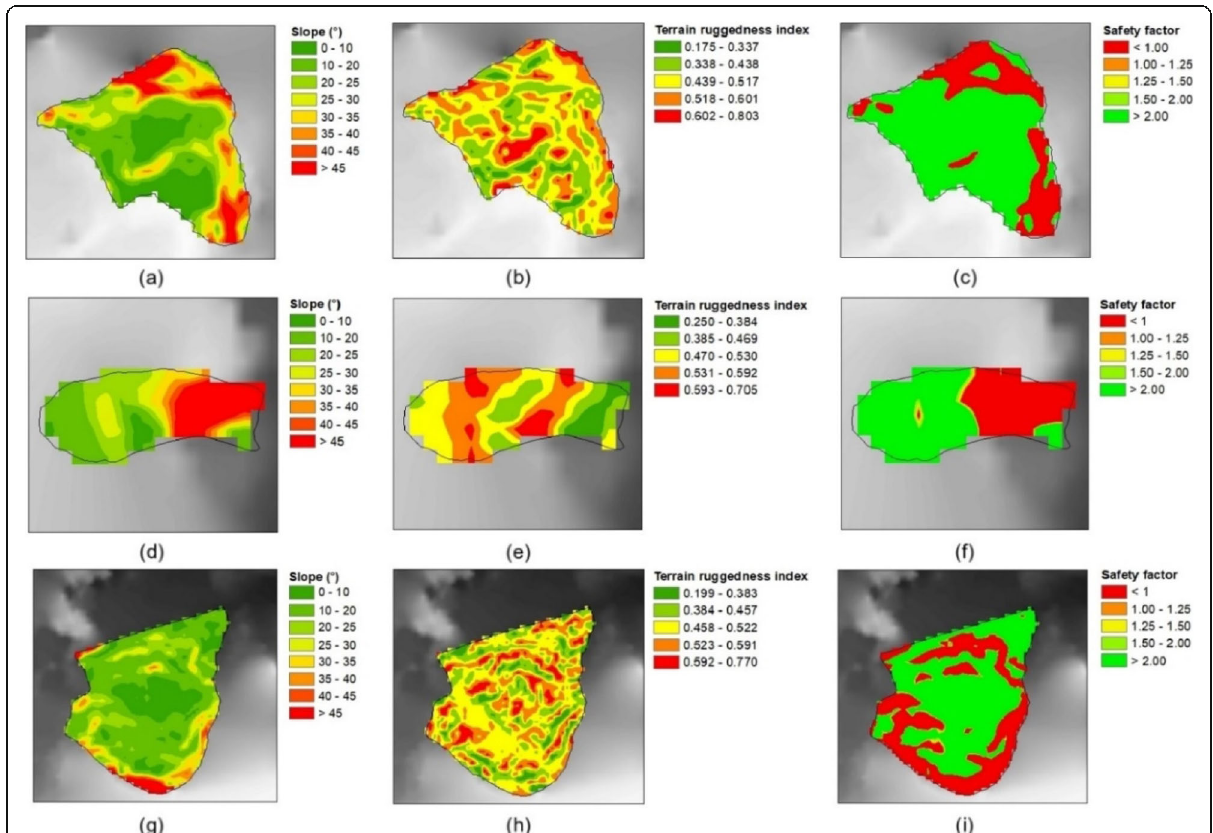
Fig. 12 Topographic indicator (slope and terrain ruggedness index) and quantitative analysis of the DEM (safety factor). Note: ( a ) slope angle in Tegalsari; ( b ) terrain ruggedness index in Tegalsari; ( c ) safety factor in Tegalsari; ( d ) slope angle in Wonogiri; ( e ) terrain ruggedness index in Wonogiri; ( f ) safety factor in wonogiri; ( g ) slope angle in Manglong; ( h ) terrain ruggedness index in Manglong; ( i ) safety factor in Manglong